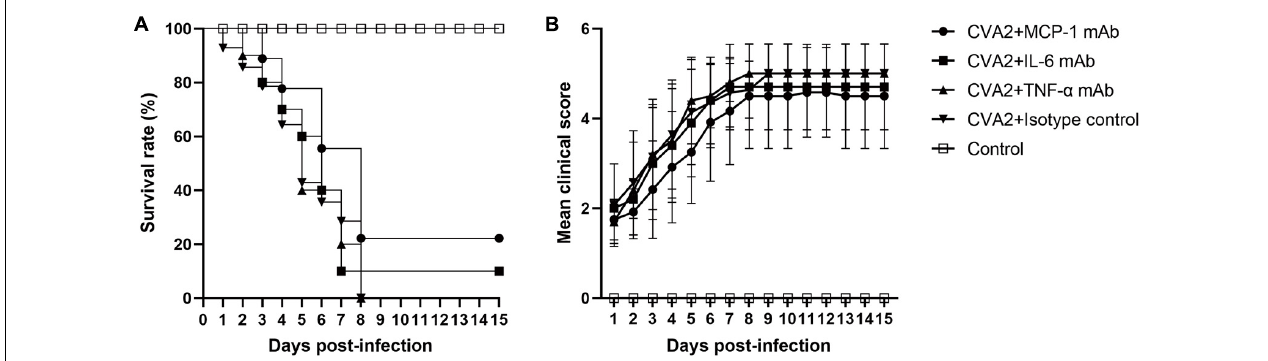
FIGURE 6 | The therapeutic effect of mAb treatment in the CVA2 infection mouse model. Five groups (n = 7 per group) of 5-day-old mice were inoculated i.m. with 10 4 TCID 50 /mouse of CVA2. After 12 h, mice were injected i.p. with Ultra-LEAFTM purified neutralizing monoclonal anti-mouse IL-6 (1.33 mg/kg), TNF- α (50 mg/kg), and MCP-1 (10 mg/kg) IgG mAb. Suckling mice from the control group were injected with equivalent purified rat IgG1 (isotype control). The treated mice were observed daily for survival rates (A) and clinical scores (B) and there was no significant statistical difference compared with group CVA2 + Isotype control.